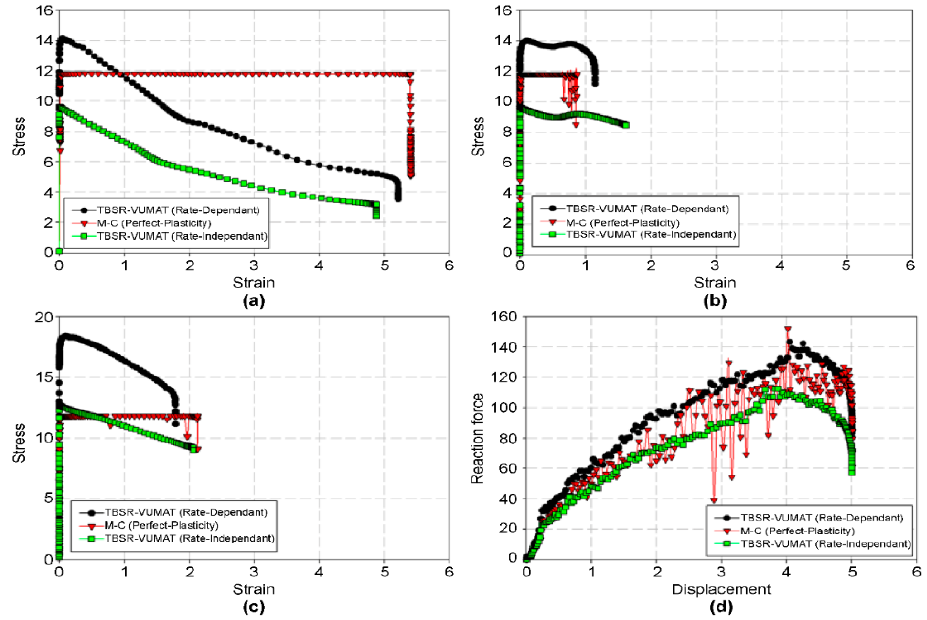
Figure 12. Results of TBSR–VUMAT and M–C models. ( a ) Point 1, ( b ) Point 2, ( c ) Point 3, and ( d ) force–displacement curve.